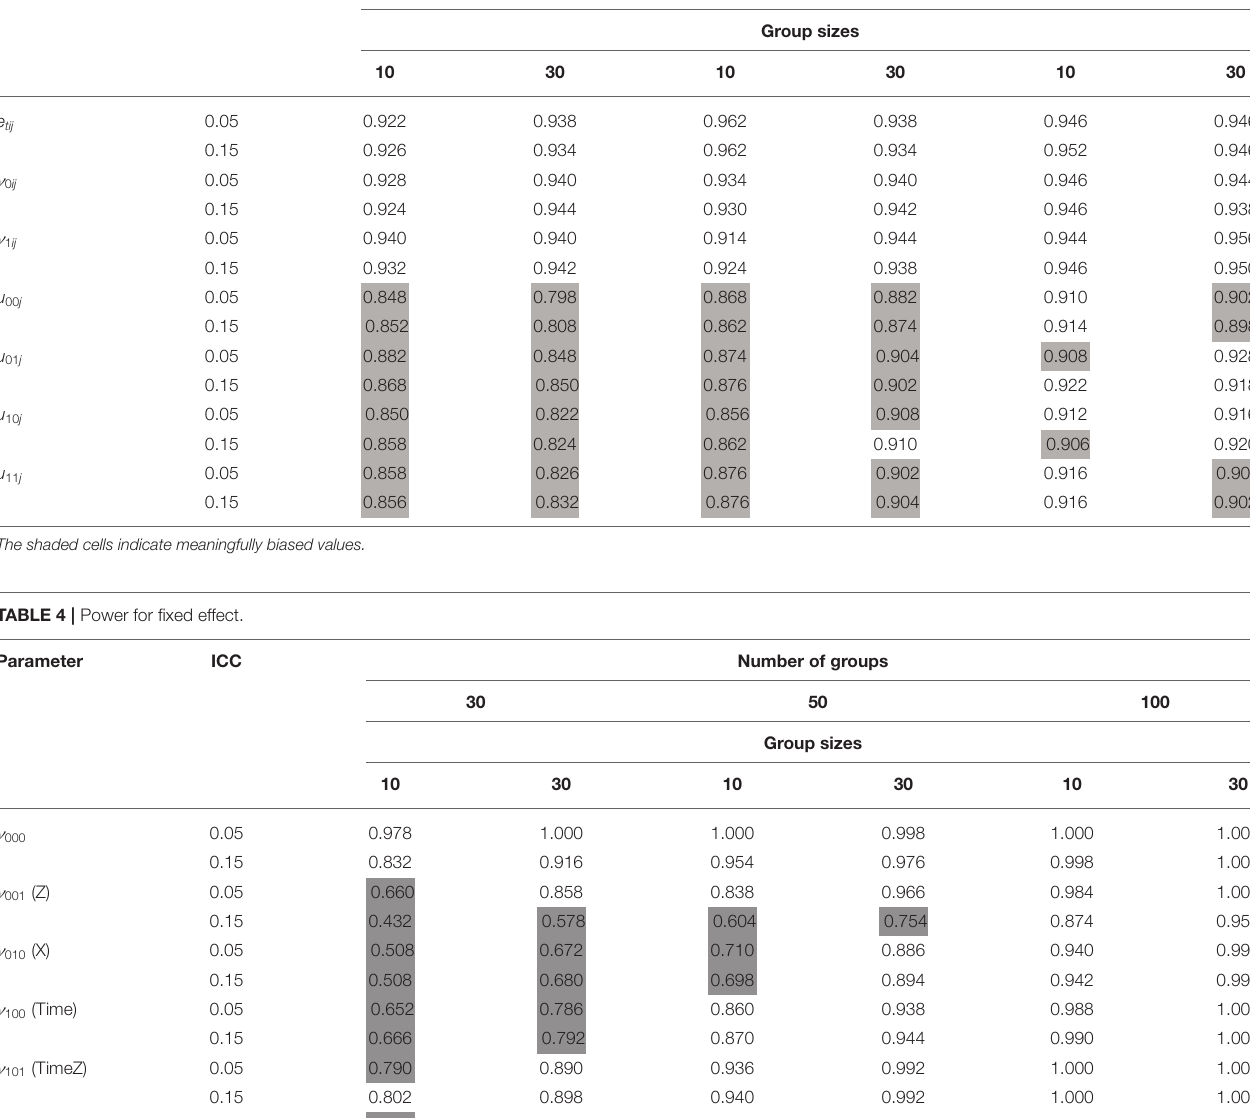
TABLE 3 | 95% coverage rate for random effect standard errors. Parameter